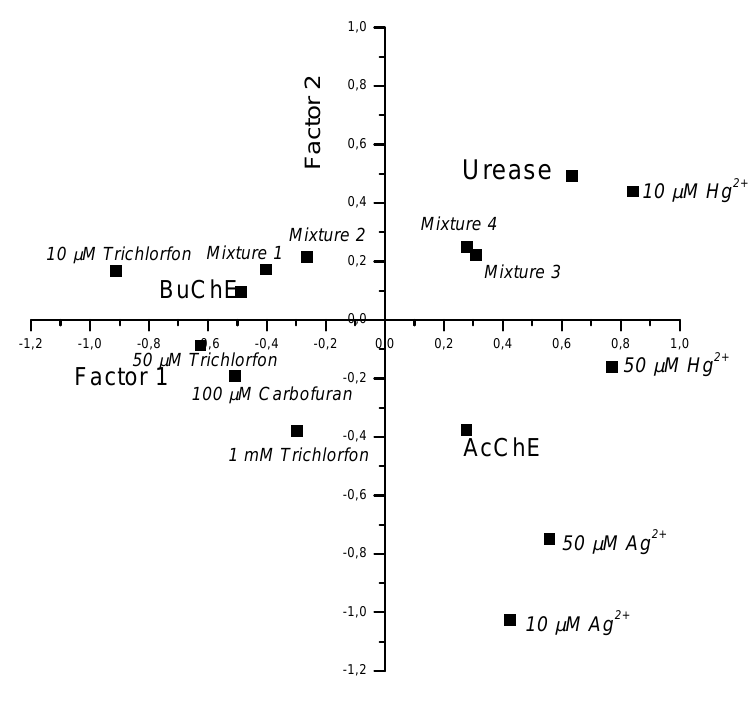
Figure 6. Representation of data from Table 4 by using multivariate correspondence analysis.